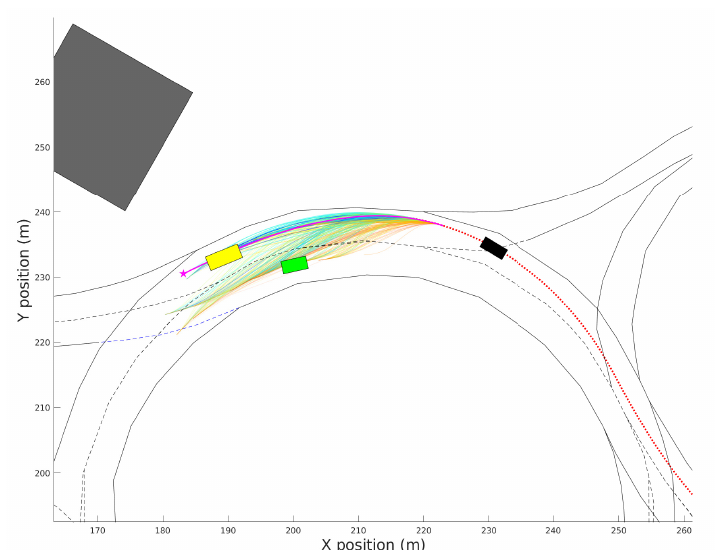
Figure 6. Candidate generation to different navigation